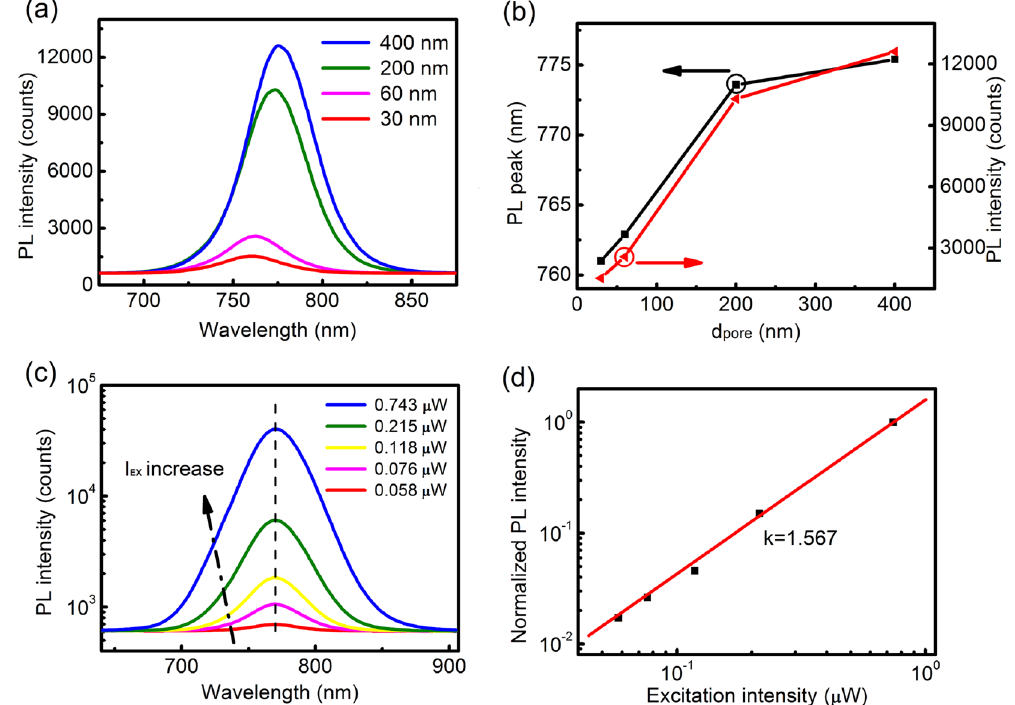
Figure 5. ( a ) PL spectra of the perovskite films on AAO templates with different size of pore; ( b ) Emission peaks and intensities of the perovskite films; ( c ) PL spectra of the perovskite film on AAO template with d pore = 200 nm recorded with excitation intensity from 0.058 to 0.743 uW. All spectra are measured in air at room temperature. The peak energy is indicated by the dashed line; ( d ) Logarithm plot of the integrated PL intensity versus excitation intensity.